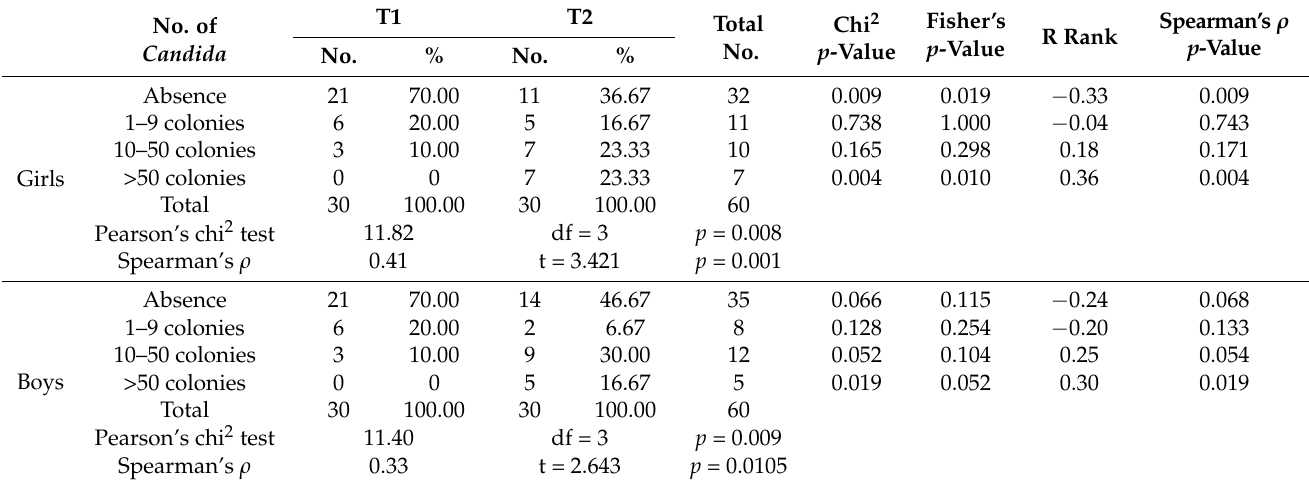
Table 3. Analysis of the relationship between fungal colony results and patient gender.